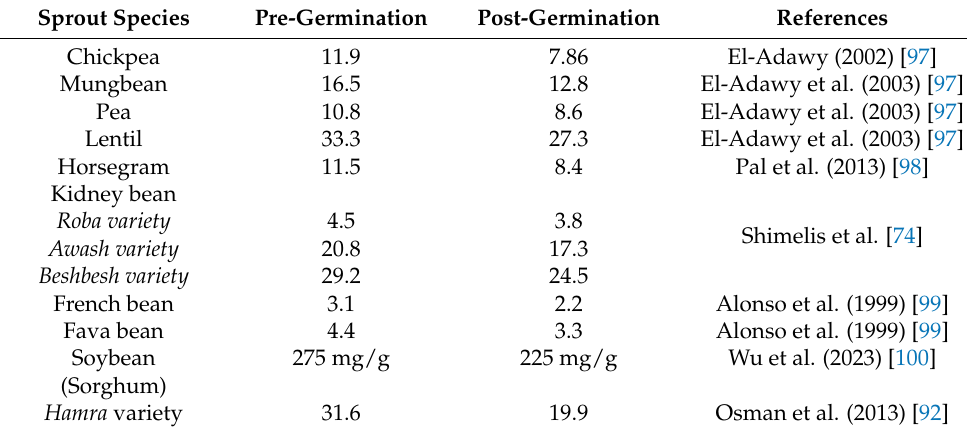
Table 6. Changes in trypsin inhibitors (in trypsin-inhibitory units/mg of protein, unless mentioned) after germination for 72 h.